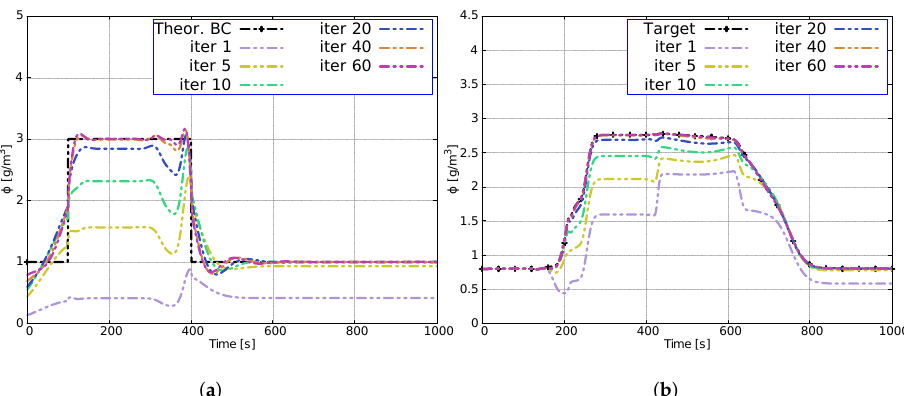
Figure 10. Case 5. Evolution of the reconstruction of the boundary condition ( a ) and evolution of the target ( b ) in some